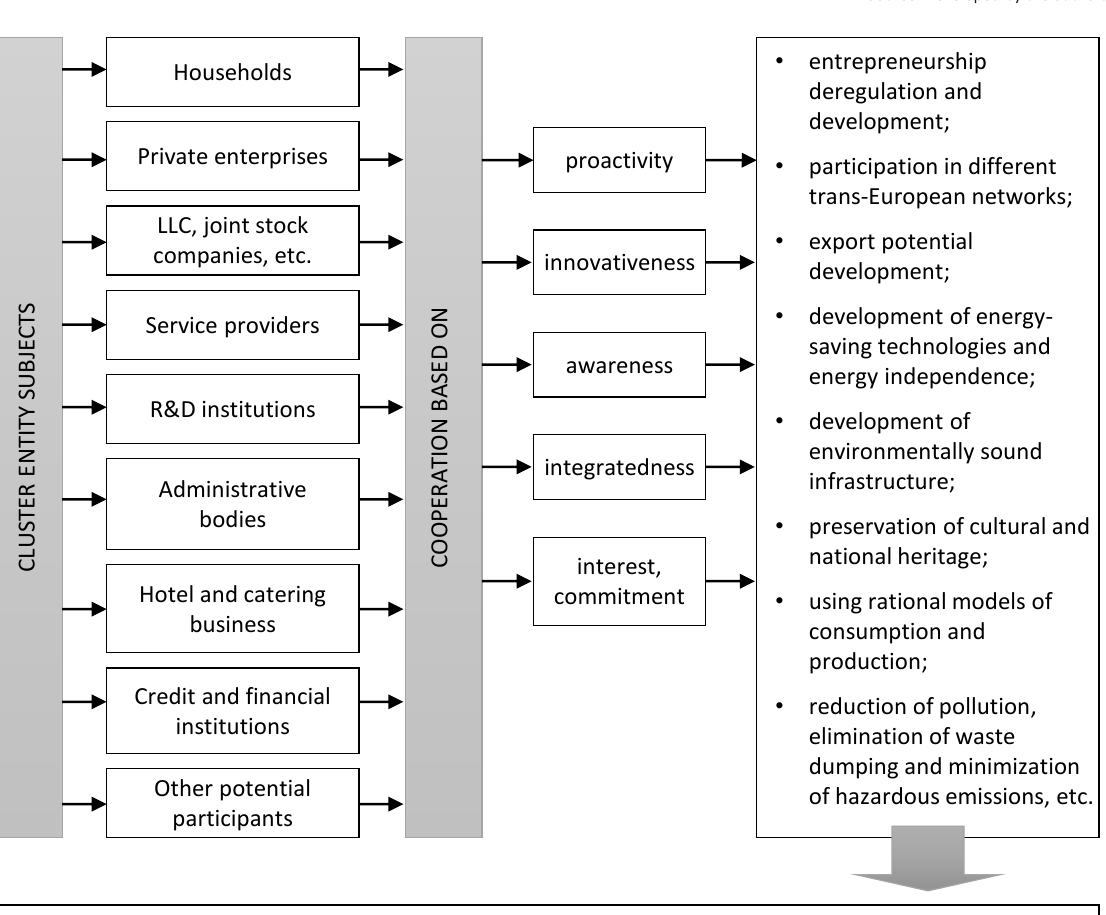
Figure 4. Cluster-based model of the agrarian sector sustainable